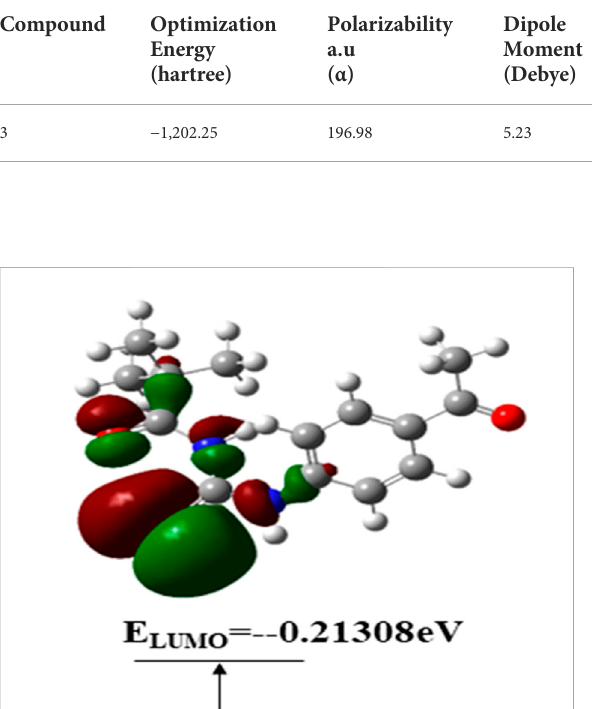
TABLE 2 Geometric parameters of the compound 3.